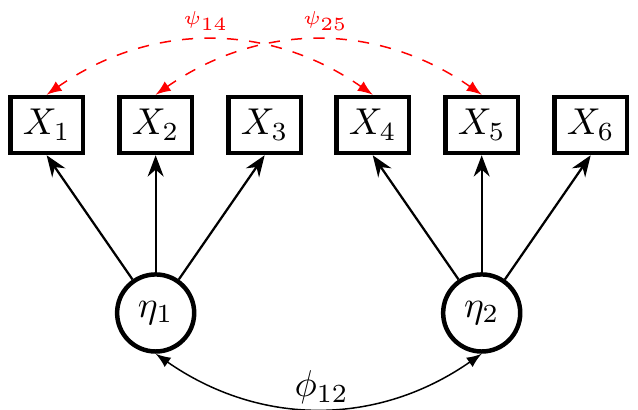
Figure 1. Simulation Study 1: Data-generating model.